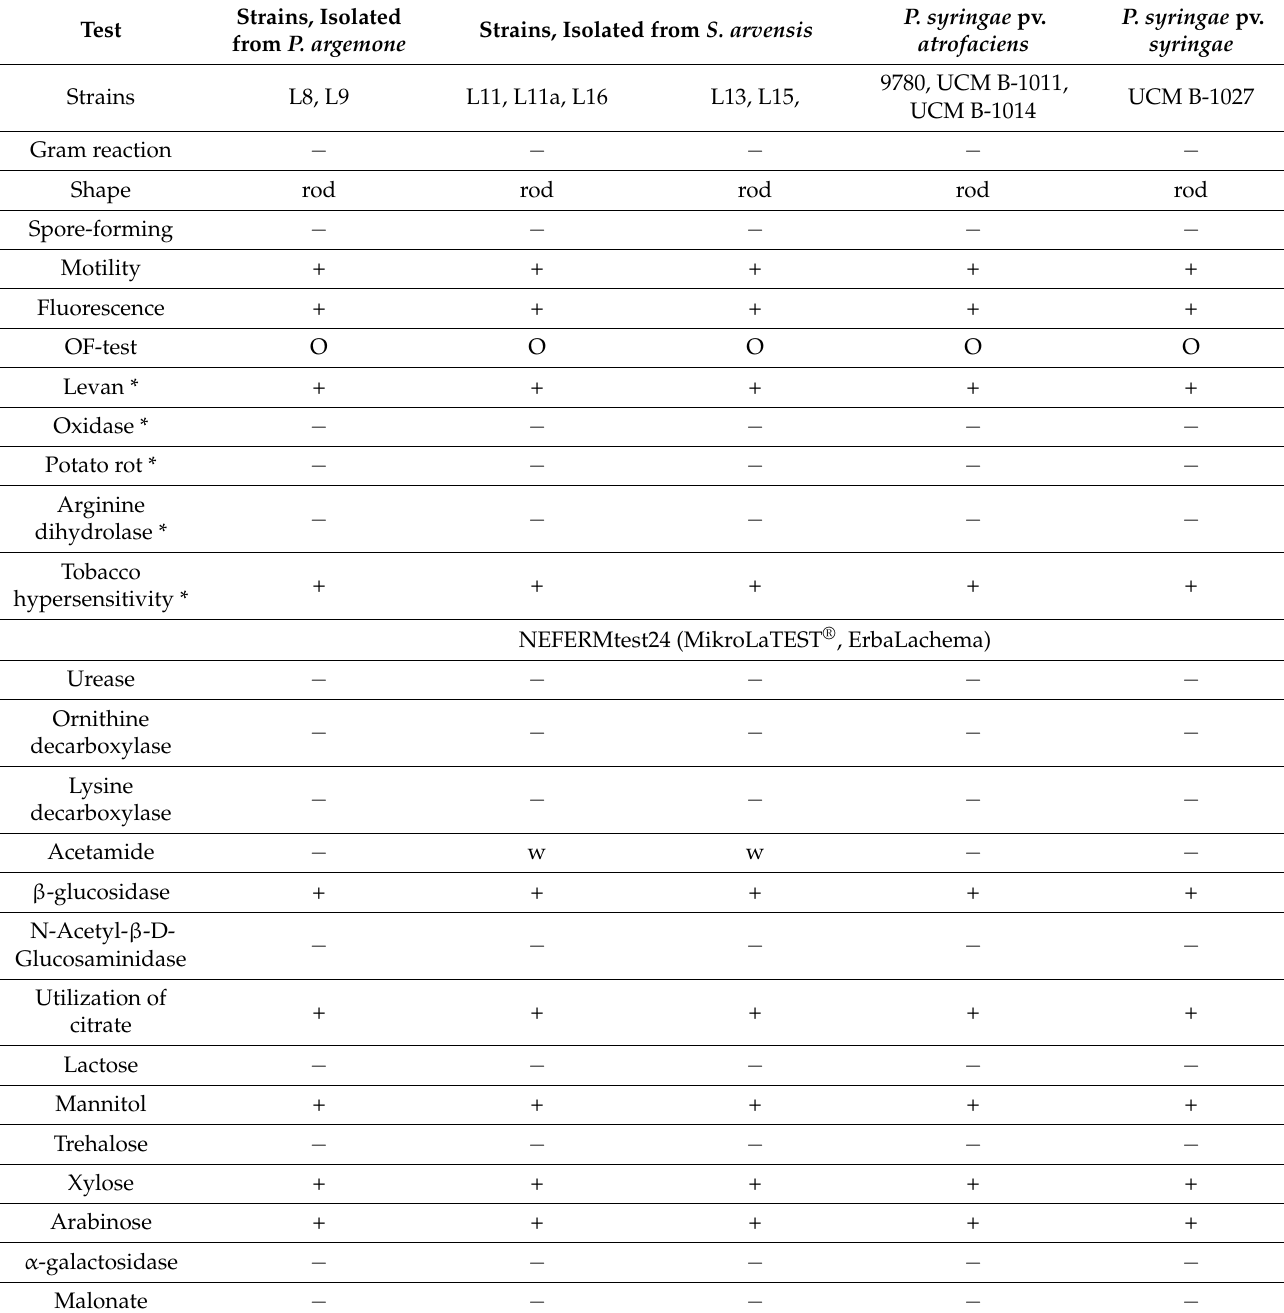
Table 1. Physiological and biochemical properties of bacteria used in this